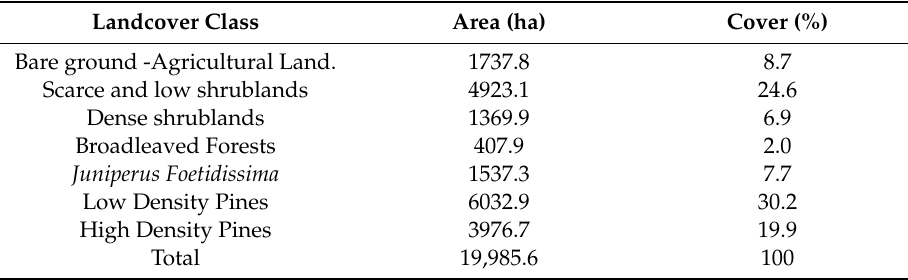
Table 2. Landcover classes identified in the study